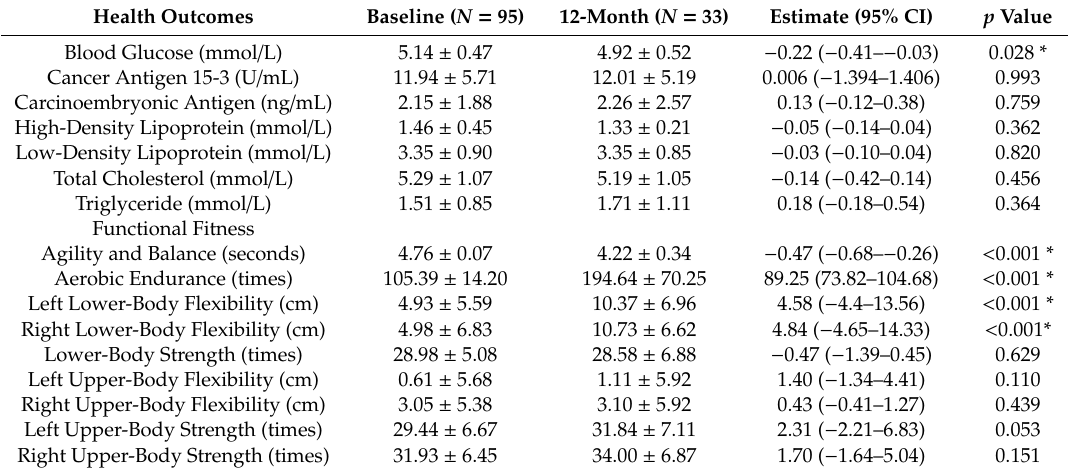
Table 4. Inferential statistics for baseline and posttest on health